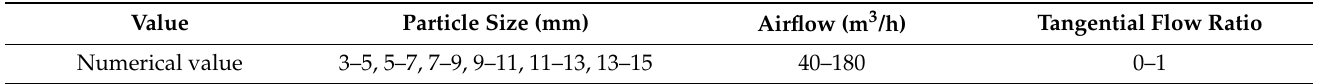
Figure 4. Split view of swirling generator [6]. 12—Gas nozzle, 13—inlet pipe, 14—right cover, 15—adjusting ring, 16—housing, 17—swirling blade, 18—regulating sleeve, 19—pebble particles, 20—outlet pipe. Table 2. Experimental